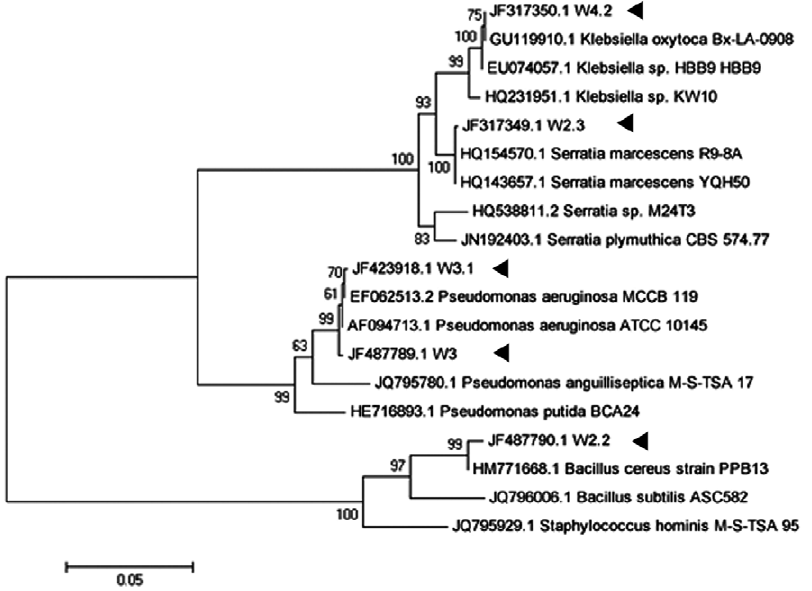
Figure 1. Phylogenetic analysis of the 16S rDNA sequences of isolated bacterial strains. The tree is based on maximum-likelihood (Tamura-Nei model) analysis. Bootstrap values (expressed as percentages of 1,000 replications) are shown at branch points. Solid triangles indicate the positions of isolated bacteria in phylogenetic analysis. Bar represents evolutionary distances as 0.05 changes per nucleotide position. W4.2: Klebsiella sp.; W2.3: Serratia sp.; W3 and W3.1: Pseudomonas sp.; and W2.2: Bacillus sp.